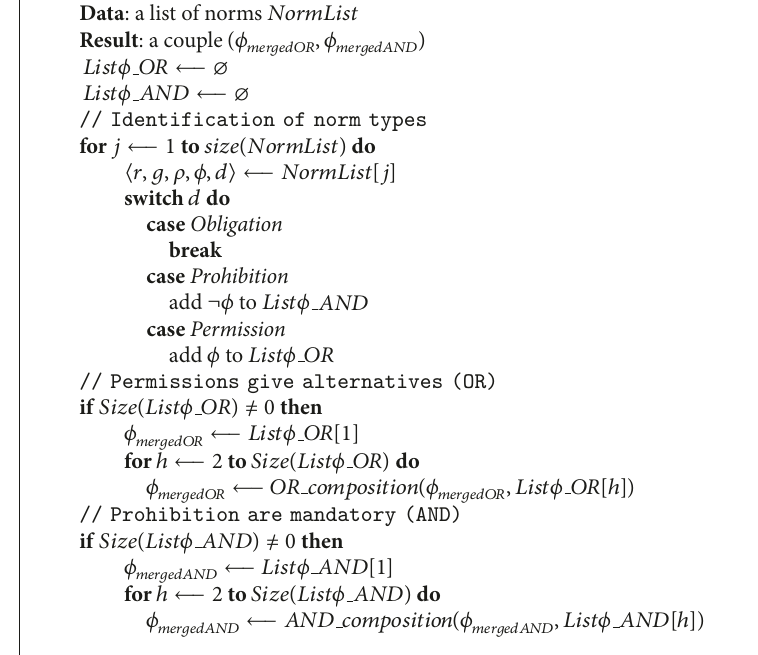
Algorithm 5: Compose Norm